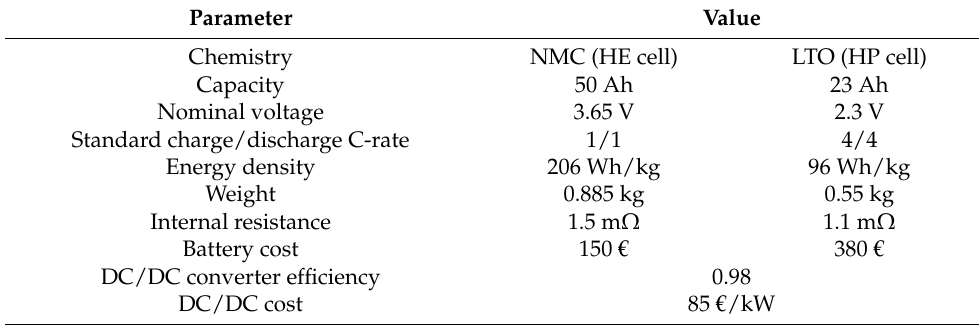
Table 1. Battery and DC/DC converter specifications.